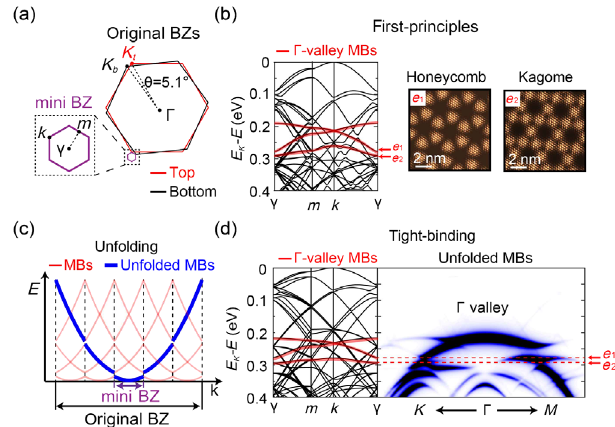
FIG. 4. Calculation on TB WSe 2 . (a) Original BZs of a bilayer WSe 2 with a twist angle θ ¼ 5 . 1 ° and resulting mini BZ of TB WSe 2 superlattices. The BZs of top layer, bottom layer WSe 2 , and the mini BZ of TB WSe 2 are illustrated in red, black, and purple, respectively. High-symmetry points are labeled on BZs; the subscripts t and b stand for the top and bottom layer, respectively. (b) Left: first-principles-calculated moir´e bands (MBs) of 5.1° TB WSe 2 presented in the mini BZ. The top three Γ -valley MBs are highlighted in red. Right: calculated charge distributions at energies e 1 and e 2 (indicated by red arrows in the left-hand part), showing honeycomb ( e 1 ) and kagome patterns ( e 2 ). (c) A simplified example illustrating the band unfolding in 1D (more discussion of 2D case can be found in SM [24]). Blue and red lines show the unfolded and folded bands. (d) Left: tight-binding- calculated MBs of 5.1° TB WSe 2 presented in the mini BZ. The top three Γ -valley MBs are highlighted in red. Right: the unfolded MBs around Γ valley (along K - Γ - M direction in the original BZ). The equivalent positions of e 1 and e 2 are indicated by red arrows and dashed